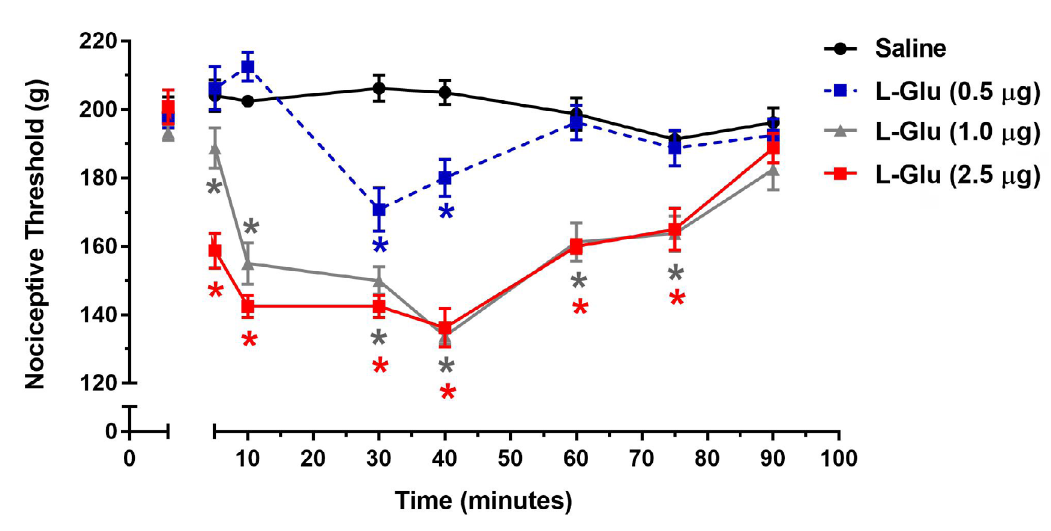
Figure 4. Temporal development of hyperalgesia induced by intraplantar injection of different doses of L-glutamate (L-Glu). L-Glu was administered via intraplantar in the doses of 0.5, 1.0 and 2.5 µg. Each symbol represents the mean ± S.E.M. of Δ of nociceptive threshold (g) for four animals. *Indicates statistical significant difference (p < 0.05) from the control group